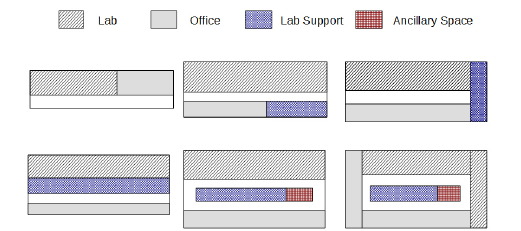
Figure 12. Typical layouts of lab-centered building units